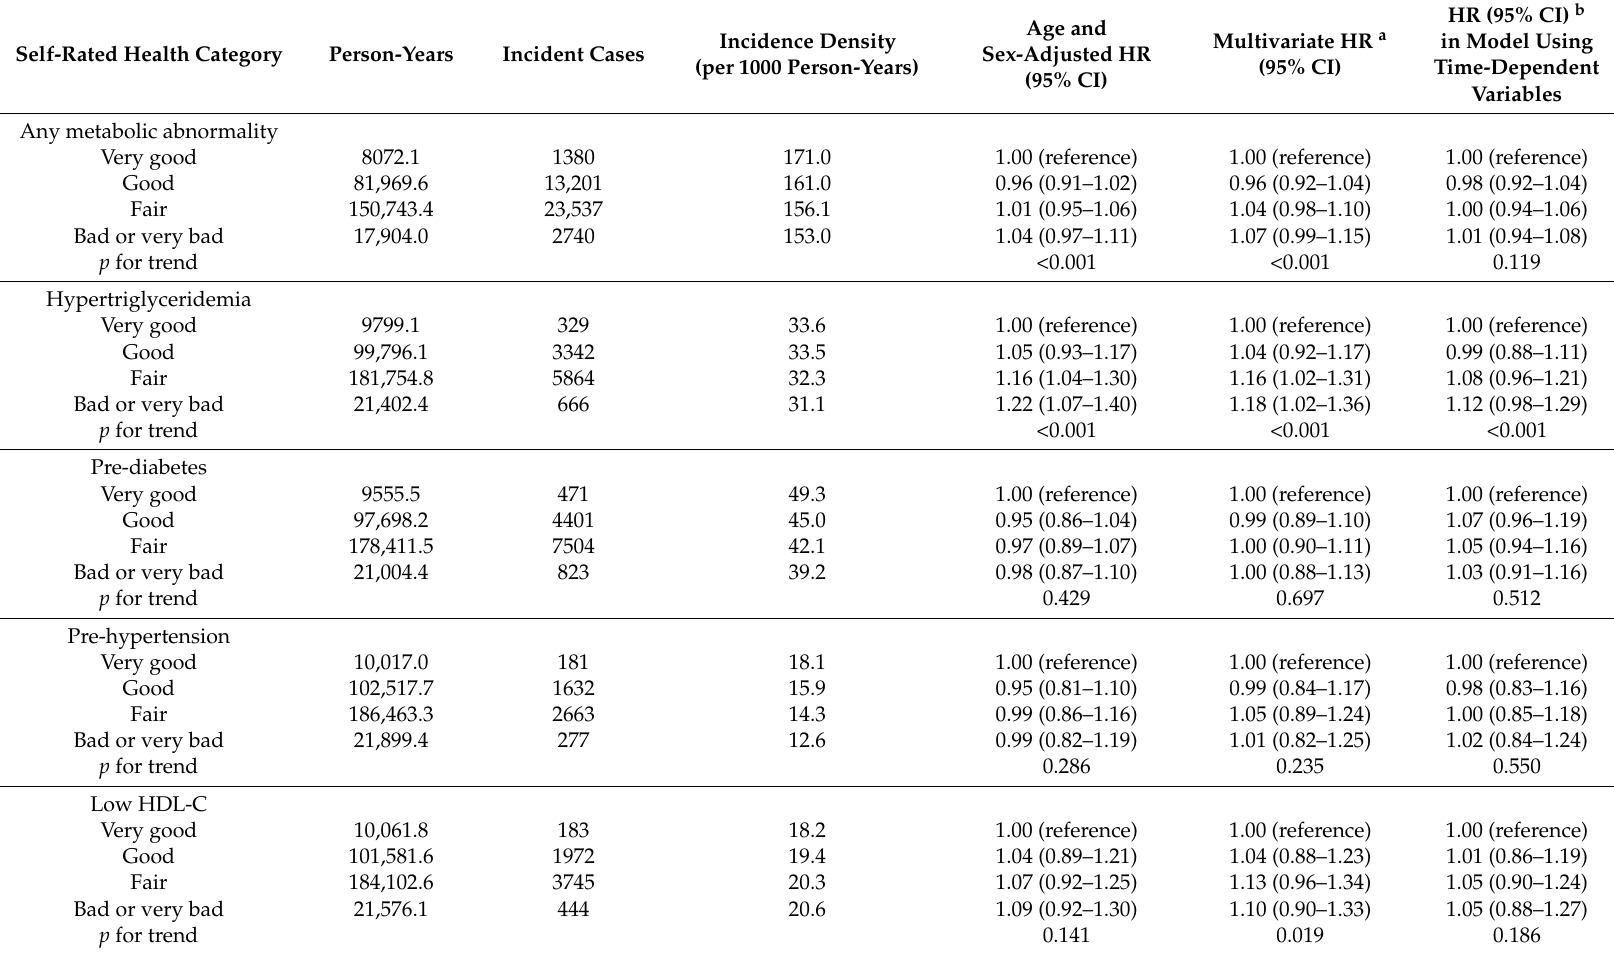
Table 2. Development of each metabolic abnormality by self-rated health